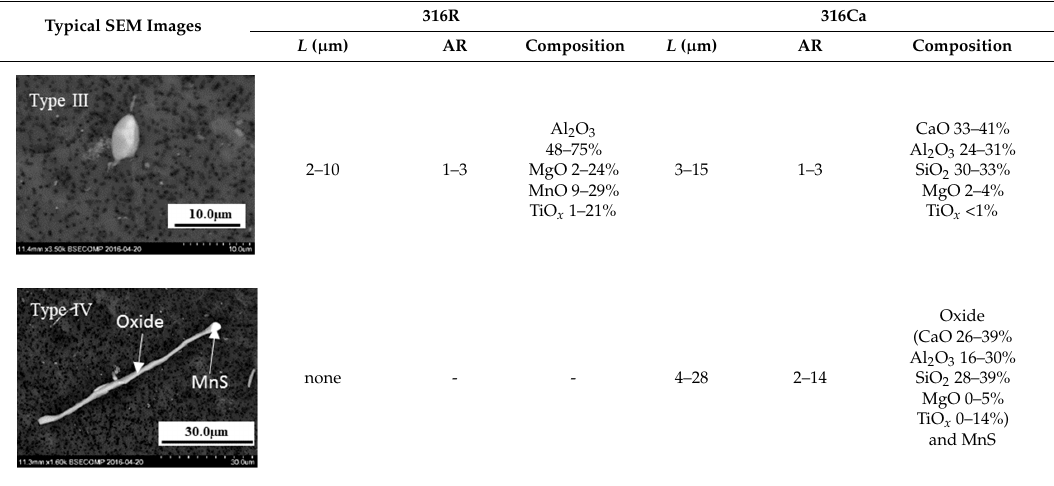
Figure 4. Element mapping of Type III ( a ) and Type IV ( b ) inclusions in Ca-treated steel.